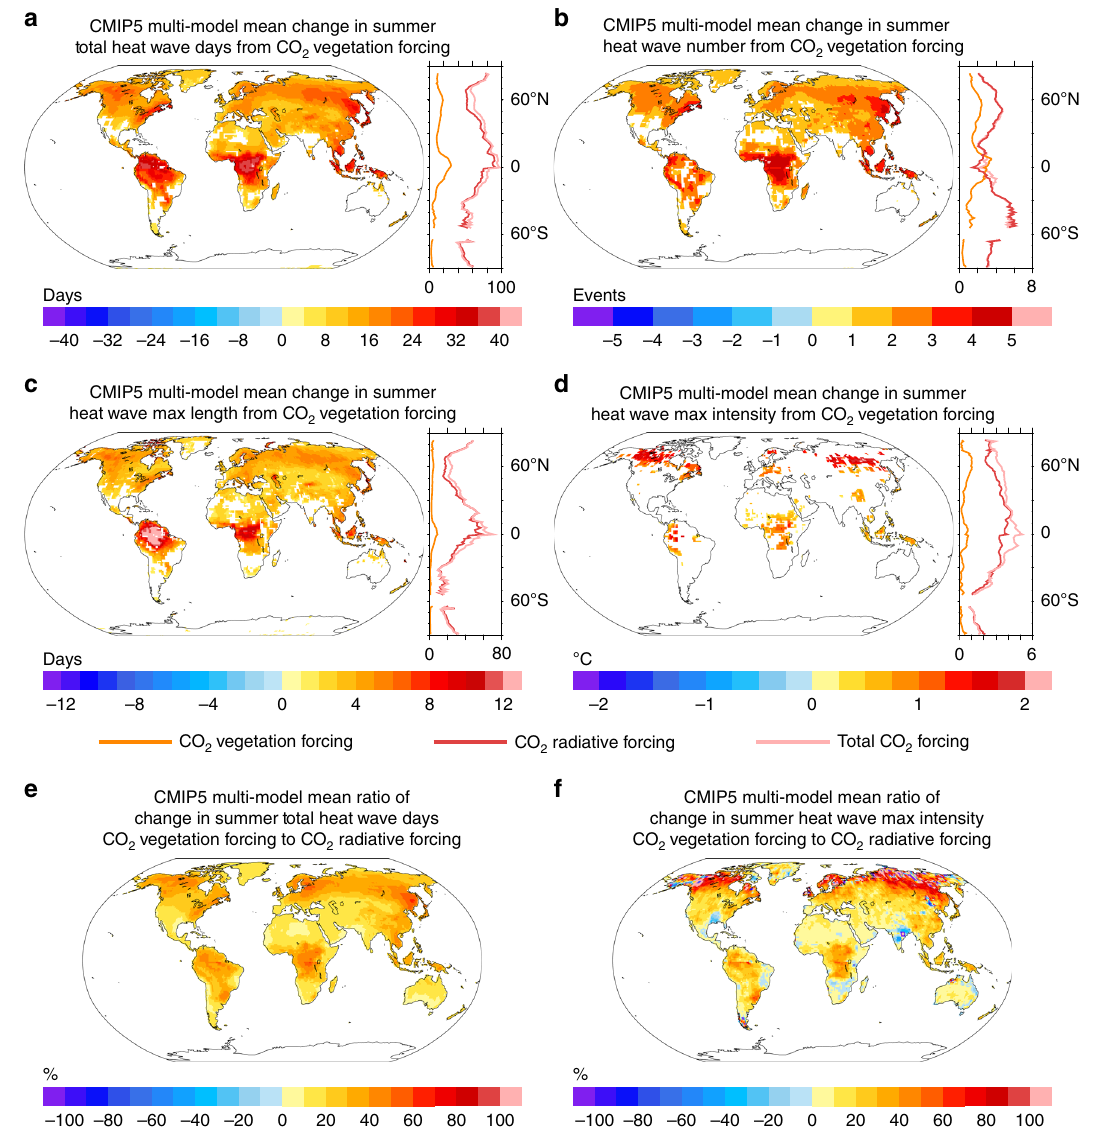
Fig. 4 Change in heat wave metrics from CO 2 vegetation forcing. Multi-model mean change in summer a total heat wave days (HWTD), b heat wave number (HWN), c heat wave maximum length (HWML), and d heat wave maximum intensity (HWMI) from CO 2 vegetation forcing (maps). Multi-model mean zonal averages of the change in each heat wave metric from (orange) CO 2 vegetation forcing, (red) CO 2 radiative forcing, and (pink) total CO 2 forcing. Only land grid points are used in the zonal averages. Multi-model mean ratio (percentage) of the change in e HWTD and f HWMI from CO 2 vegetation and CO 2 radiative forcing ([CO 2 vegetation / CO 2 radiative] × 100). Only statistically signi fi cant changes are plotted in a - d (Methods). June – September (December – March) values are used in the Northern (Southern) Hemisphere. Plots represent 30-year